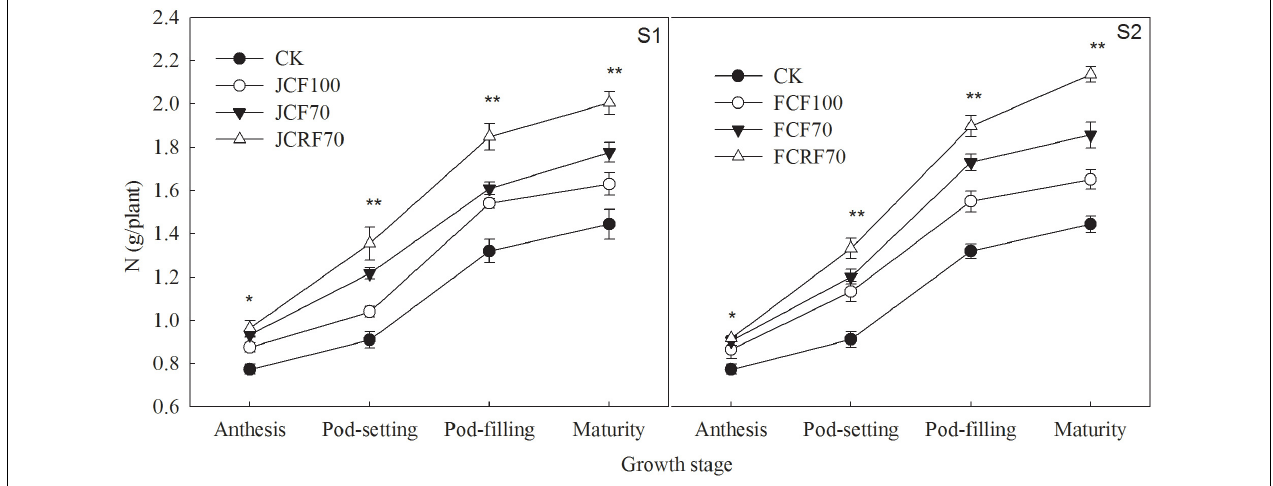
FIGURE 6 | Effect of different N fertilizer management regimes on N accumulation in peanut. Abbreviations as in Figure 2 . Means and standard errors based on three replicates are shown. NS, not significant; ∗ significant at the 0.05 probability level; ∗∗ significant at the 0.01 probability level.